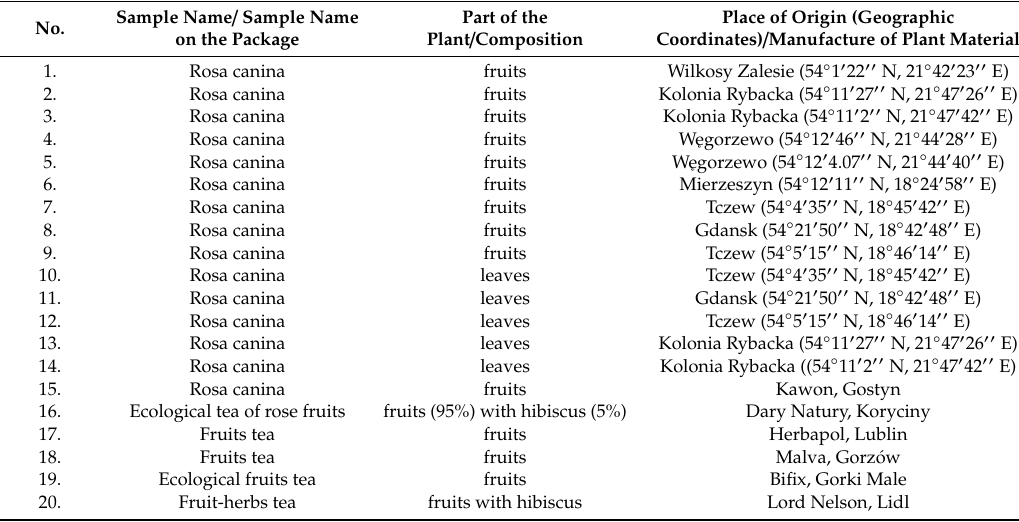
Table 4. Characteristics of Rosa canina L. samples used in this